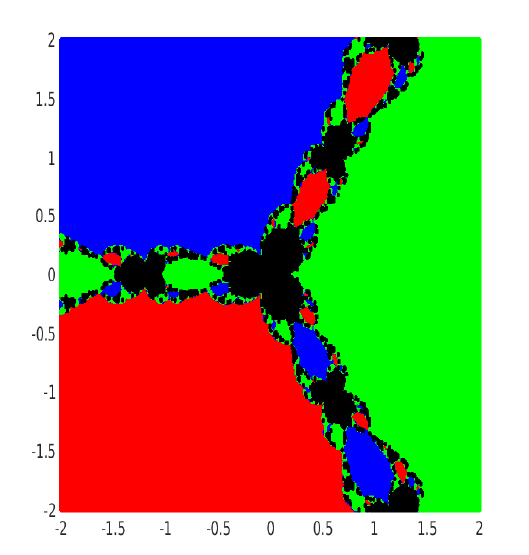
Figure 2. Dynamical plane of the methods (3) (left) and (4) (right) with basins of attraction for the Example 5.